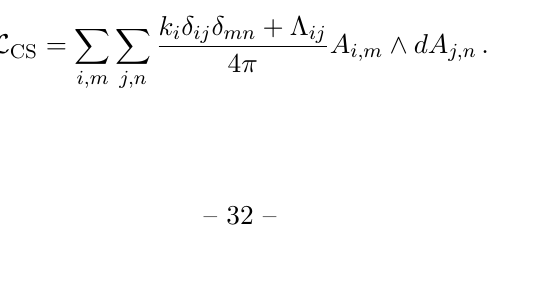
U( N ) . The triple arrows i k i i =1